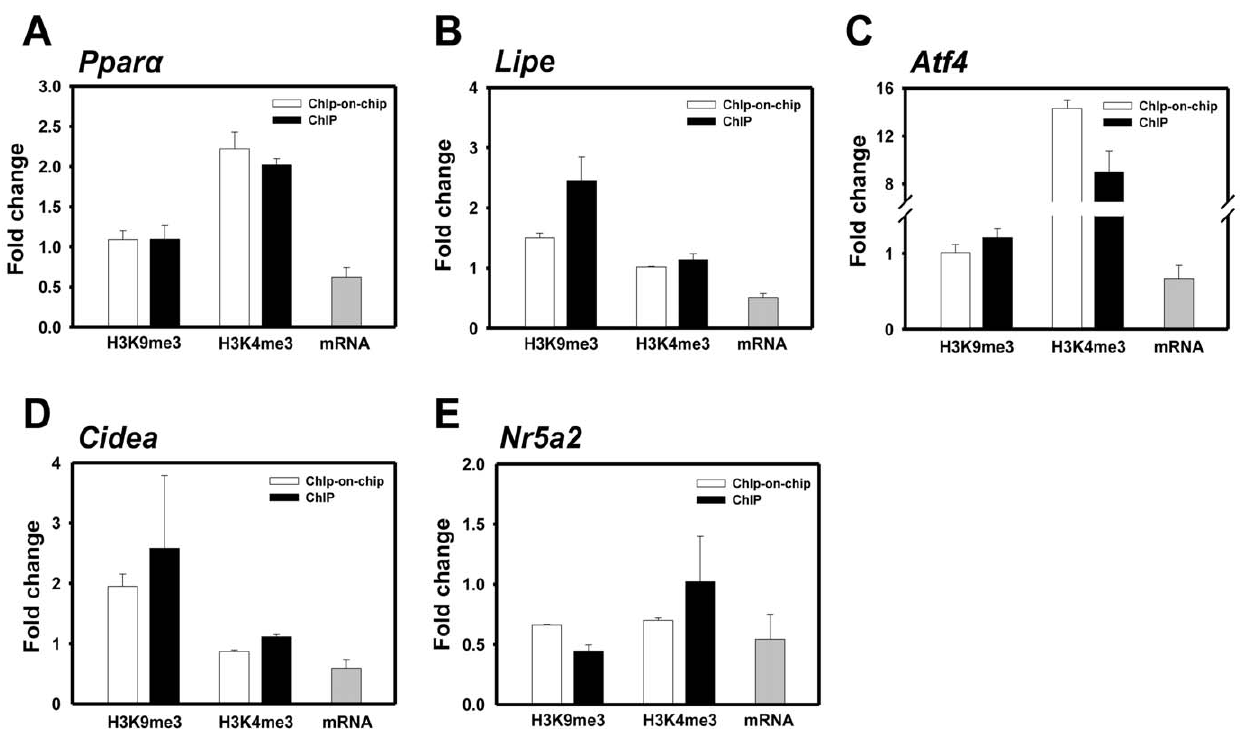
Figure 4. ChIP analysis of mRNA levels of H3K9me3 and H3K4me3 and selected Ppar a network genes (n=3).